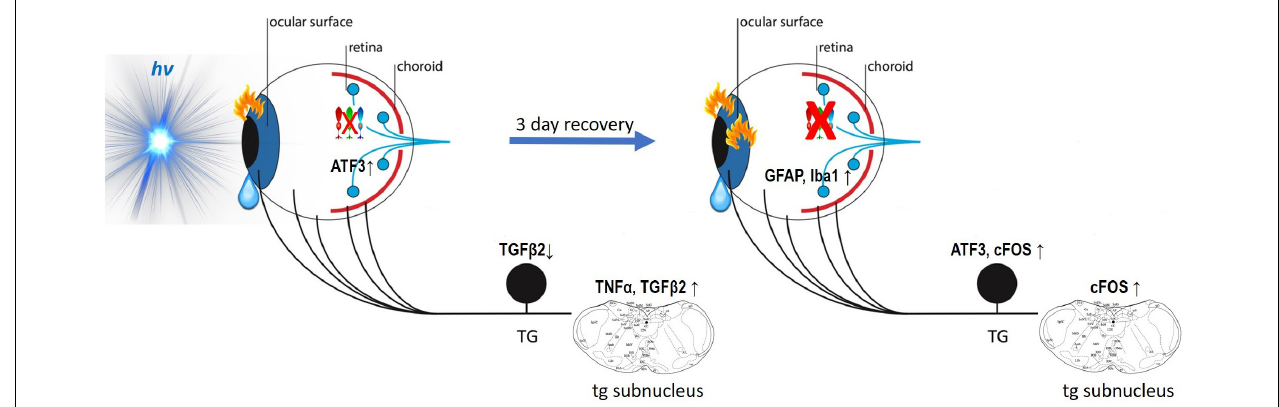
FIGURE 13 | Model of blue-phototoxicity. Proposed scheme of blue light provoked time-dependent immune and inflammatory responses in the ocular surface, trigeminal pathways and the retina. For more detail, see the “Discussion”